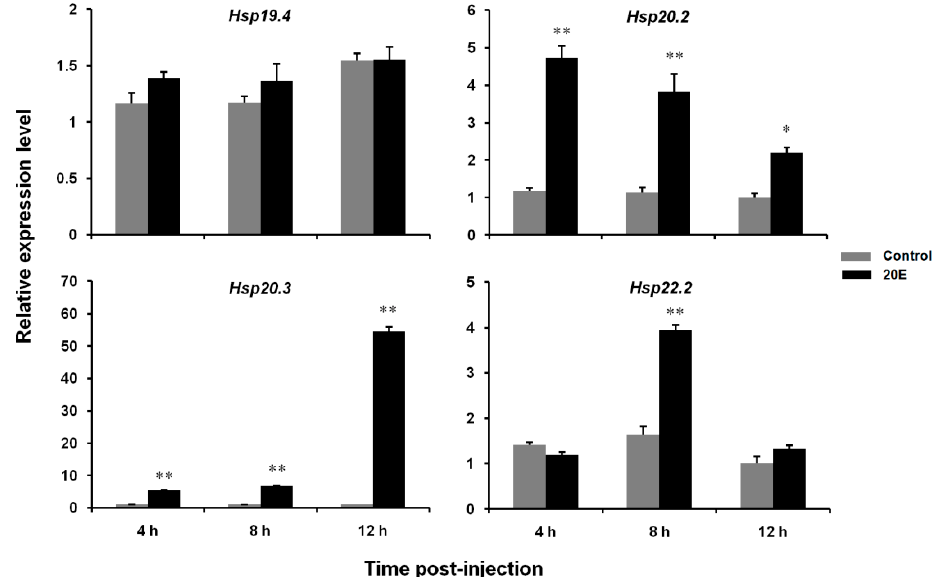
Figure 5. Relative expression levels of four LsHsp genes in L. serricorne in response to 20E induction. Larvae were collected for qPCR analysis at 4, 8, and 12 h after injection with 20E. The corresponding amount of distilled water containing 0.1% ethanol was used as a control. Significant differences between treatment and control were determined using a t test and indicated by * ( p < 0.05) or ** ( p < 0.01).